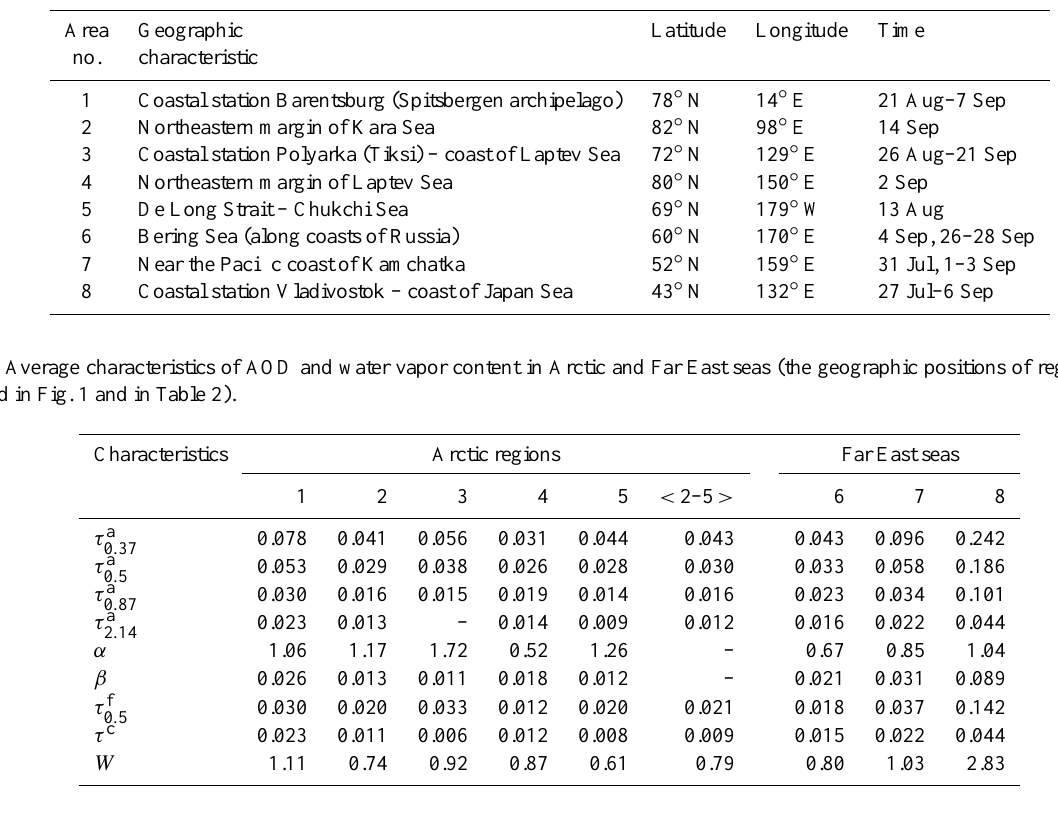
Table 2. Geographic positions of regions and periods of Sun photometer measurements.